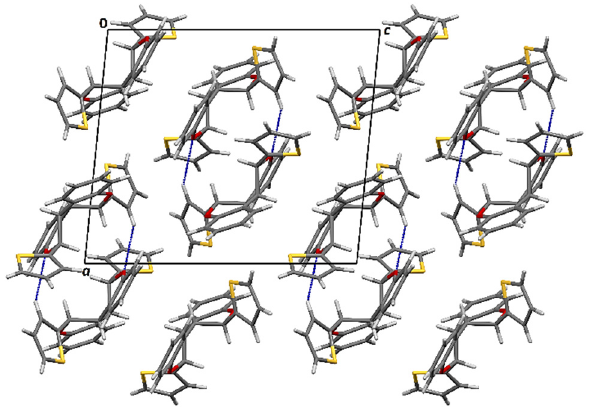
Figure 5. Crystal packing of dimer 2 viewed in the direction [010]. Two dimer molecules are linked by C3–H3 ∙∙∙ O2 hydrogen bonds. Table 1. Geometric parameters of hydrogen bonds determined from geometric analysis (A repre- sent the hydrogen bond acceptor; Symm. Op. On A means Symmetry operation on A).